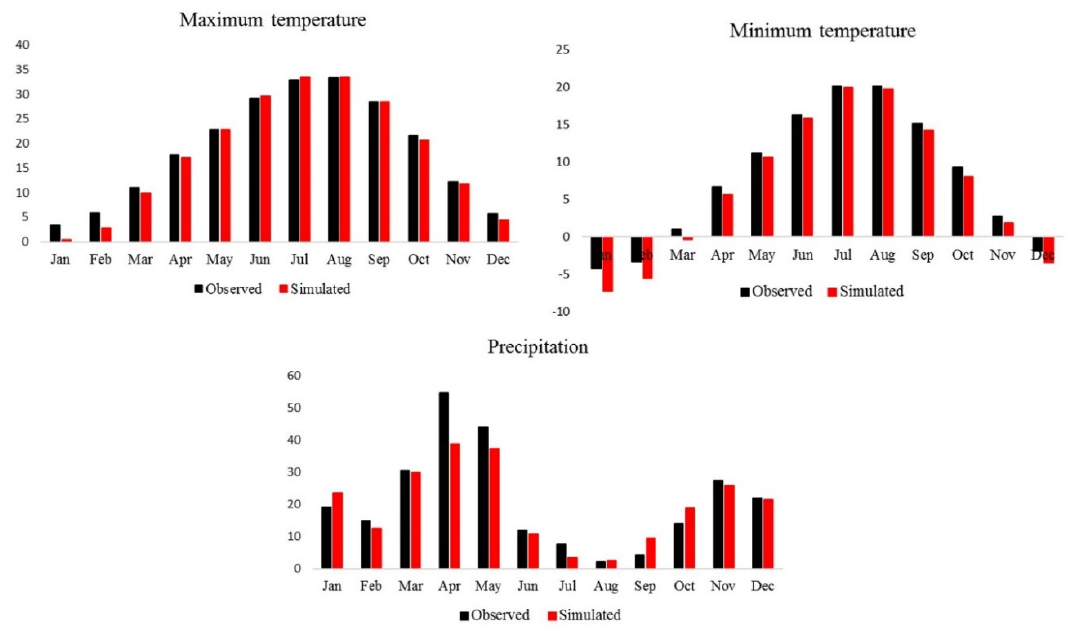
Figure 4. Validation of Statistical Downscaling Model (SDSM) performance for minimum temperature, maximum temperature, and precipitation by comparing the monthly mean for the observed and simulated data for Tabriz station during 1991–2005.